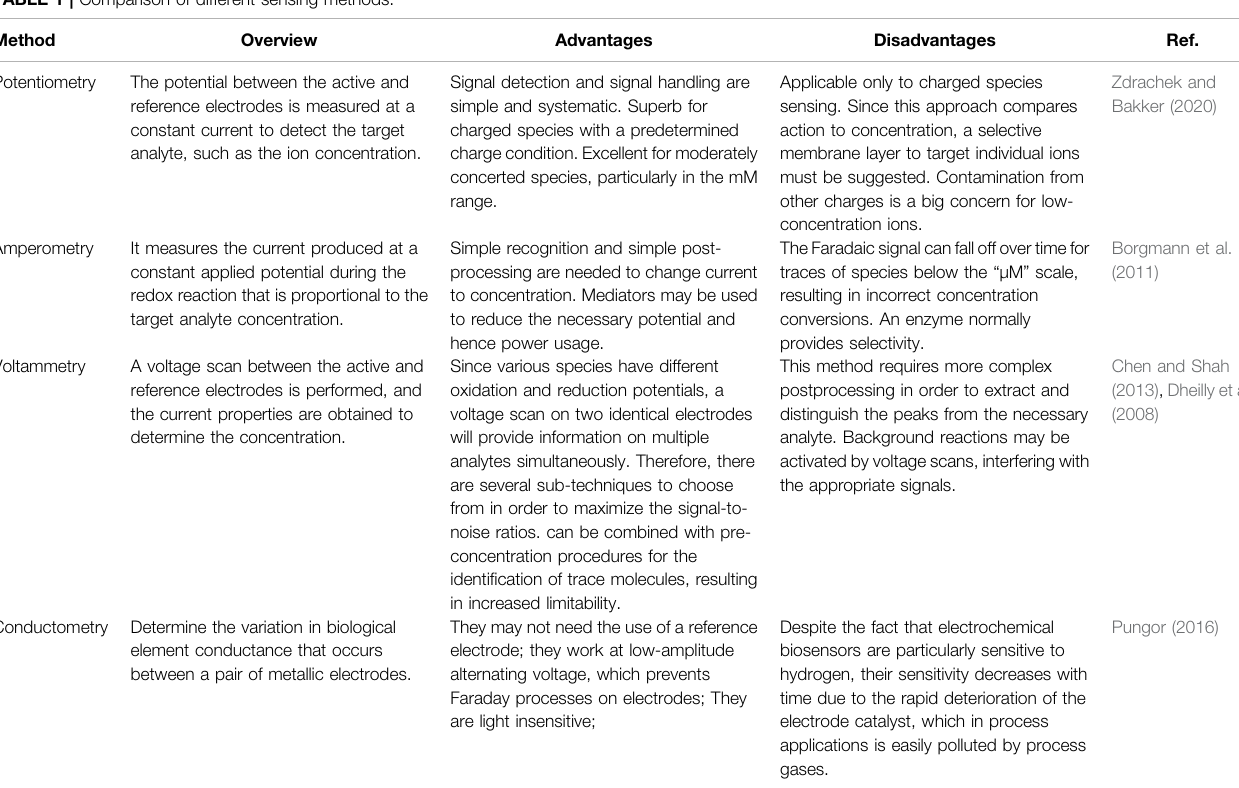
TABLE 1 | Comparison of different sensing